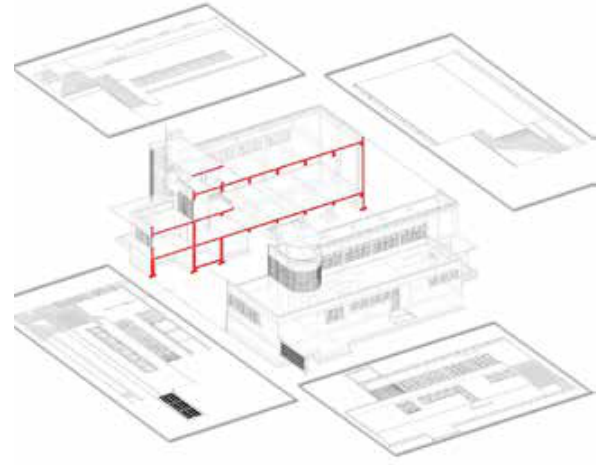
Figure 12. Blueprints for 3D modeling of the 'Casa rionale del Balilla di via Guastalla'. BIM model by G. Businaro.